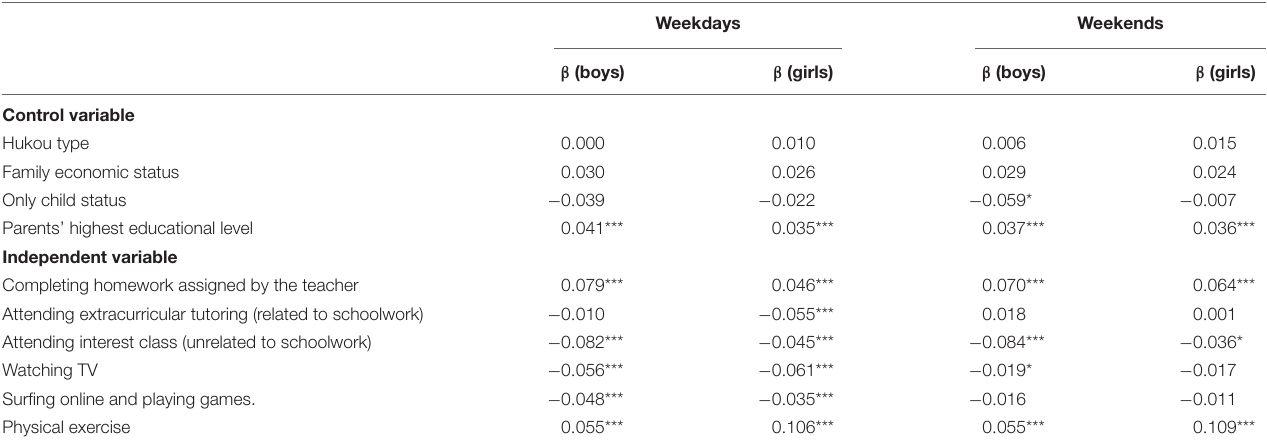
TABLE 5 | Gender differences in the fixed effects of extracurricular activities on cognitive